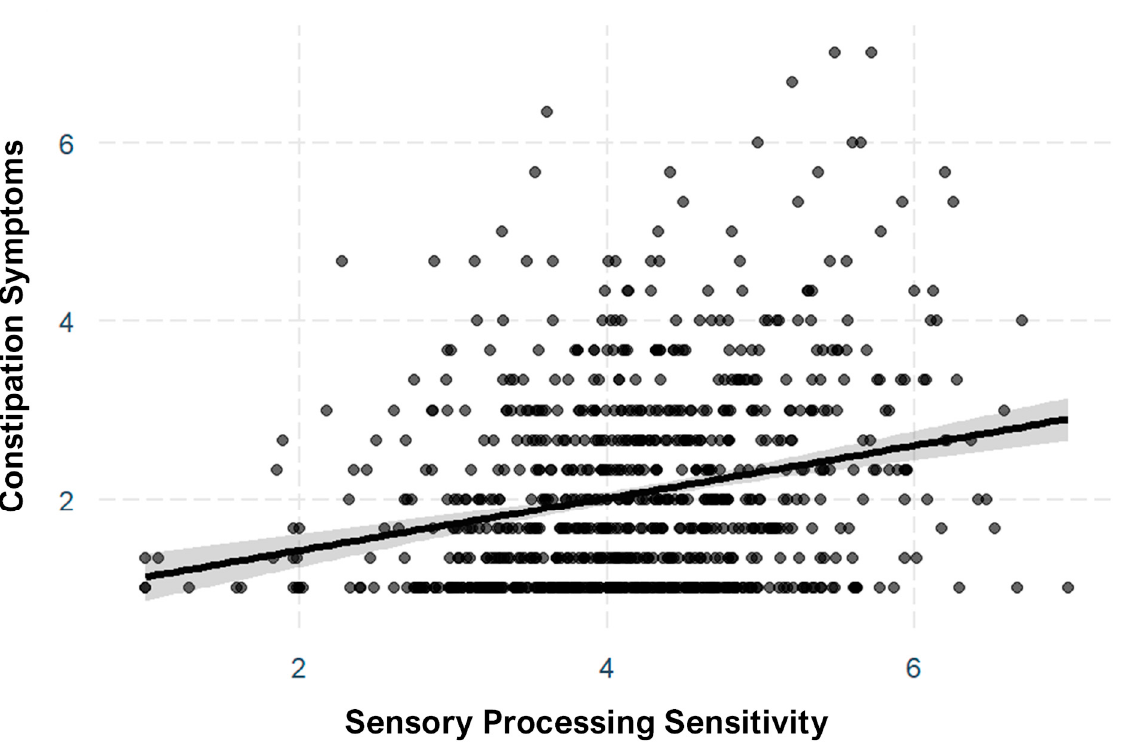
Figure A5. A Plot of the Regression Line Showing the Relationship between the Constipation Symptoms and Sensory Processing Sensitivity.